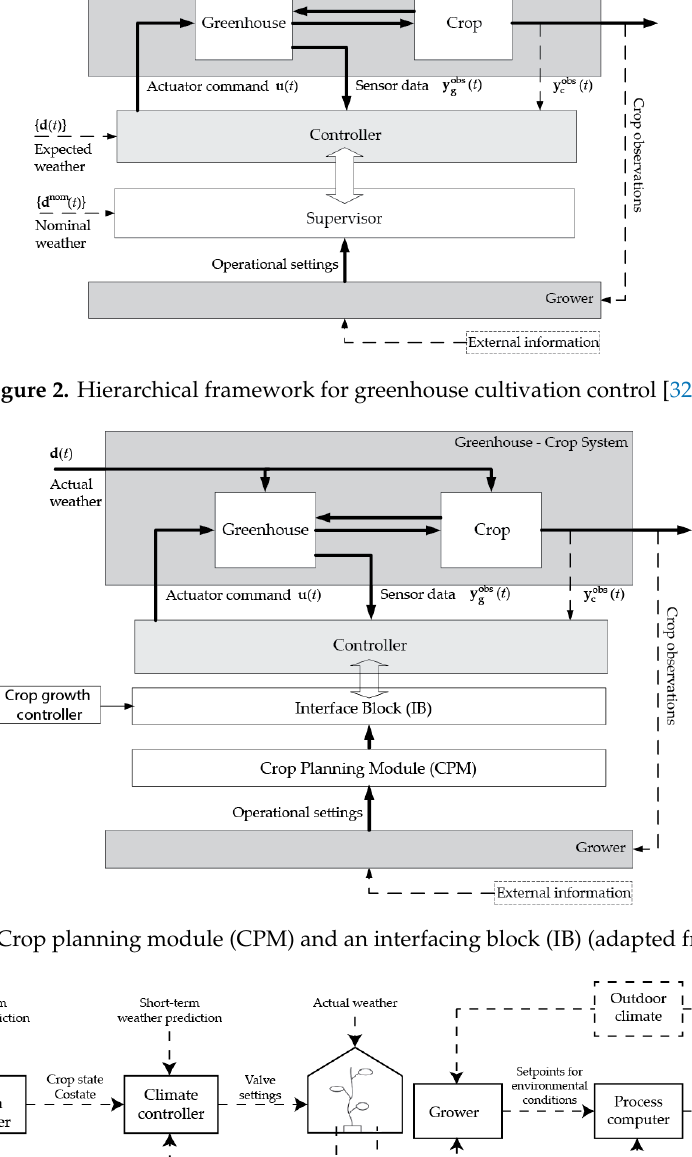
Figure 4. Optimal greenhouse climate management and “classical” climate control procedure in current horticultural practice [32]. horticultural practice